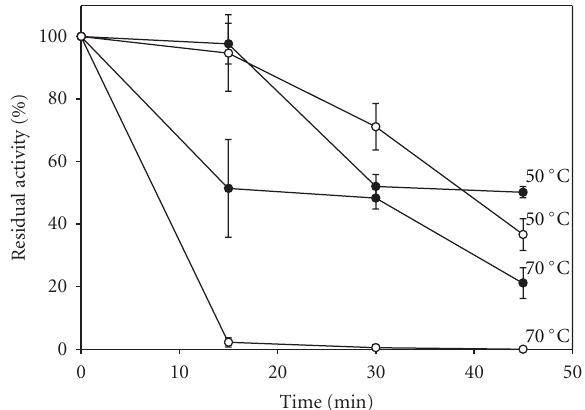
Figure 5: Thermal stability at 50 ◦ C and 70 ◦ C for the soluble ( ◦ ) and PVAG-PANIG-HRP ( •